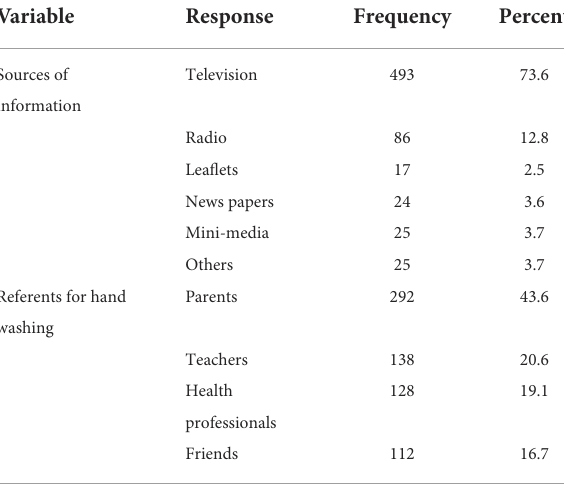
TABLE 4 Availability of hand washing facilities in primary schools in Harar town, eastern Ethiopia